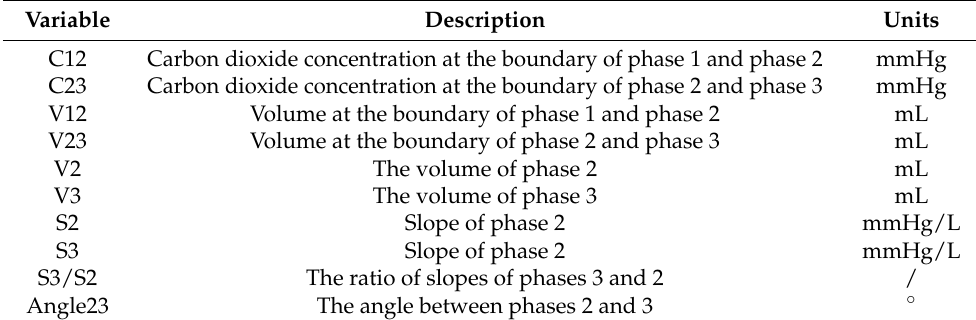
Table 2. The description of volumetric capnography features.